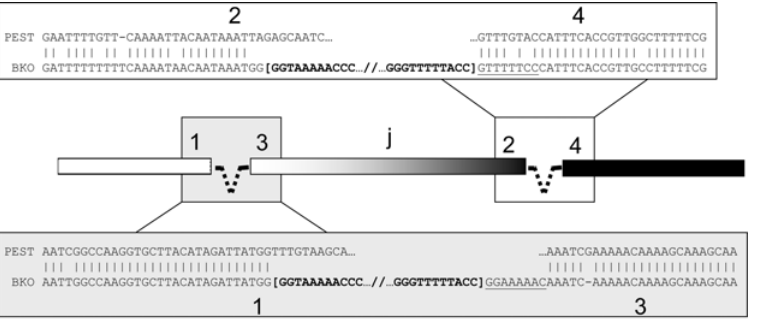
Figure 3. Sequences at the breakpoints of alternative arrangements of 2Rj. The standard arrangement represented by PEST is aligned to the inverted arrangement represented by BKO in the regions (1–4) immediately surrounding the breakpoints. Vertical lines indicate sequence identity. In bracketed bold text is the terminal sequence of the intervening inverted repeat (represented by a dashed line in the diagram). Underlined are putative target site duplications in inverse complementary orientation.